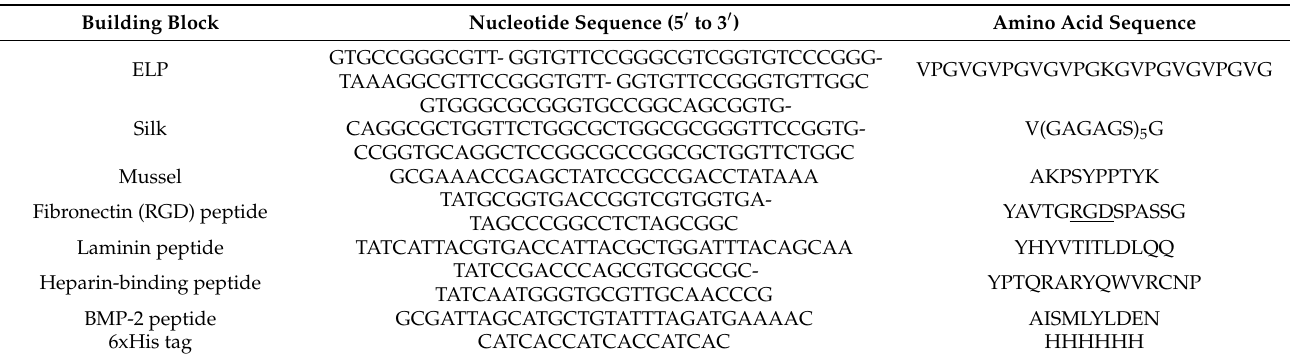
Table 1. Nucleotide and amino acid sequences of building blocks.